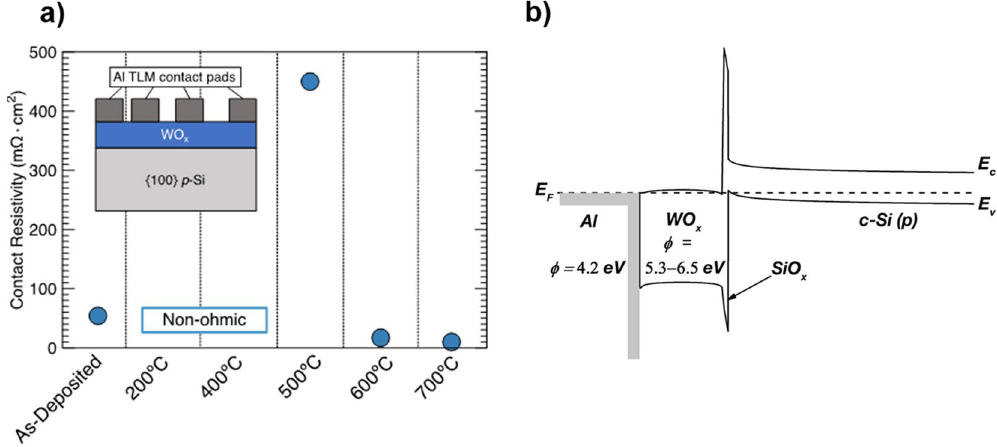
Figure 1. ( a ) Contact resistivity at various annealing temperatures obtained by TLM and ( b ) the energy band diagram of the WO x /Al contact to p- type